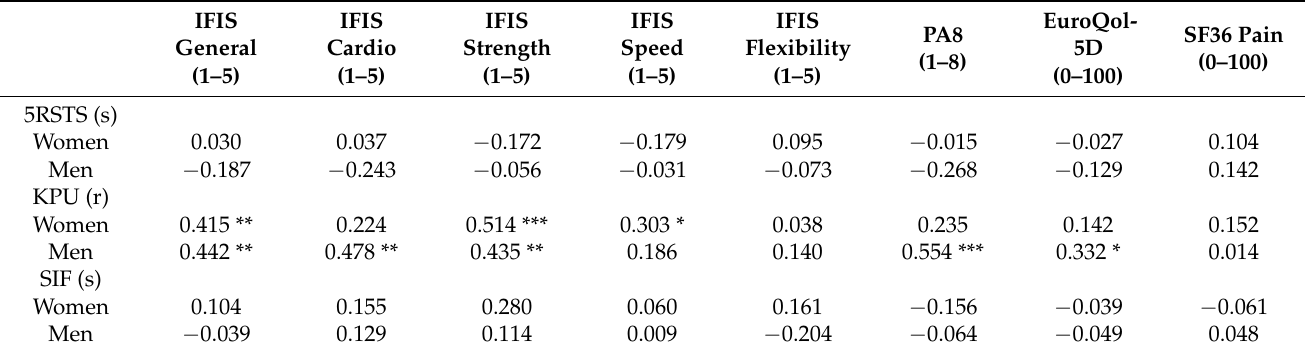
Table 5. Pearson’s partial correlation coefficients (r) between physical performance test results and questionnaire scores controlling for age in women ( n = 48) and men ( n =